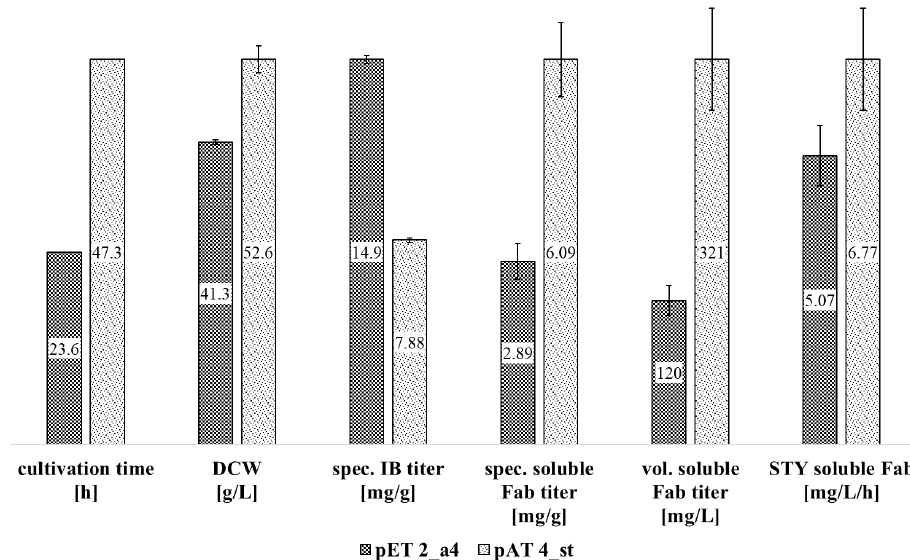
Figure 1. Comparison of cultivation times, biomass concentrations and Fab production of the T7lac